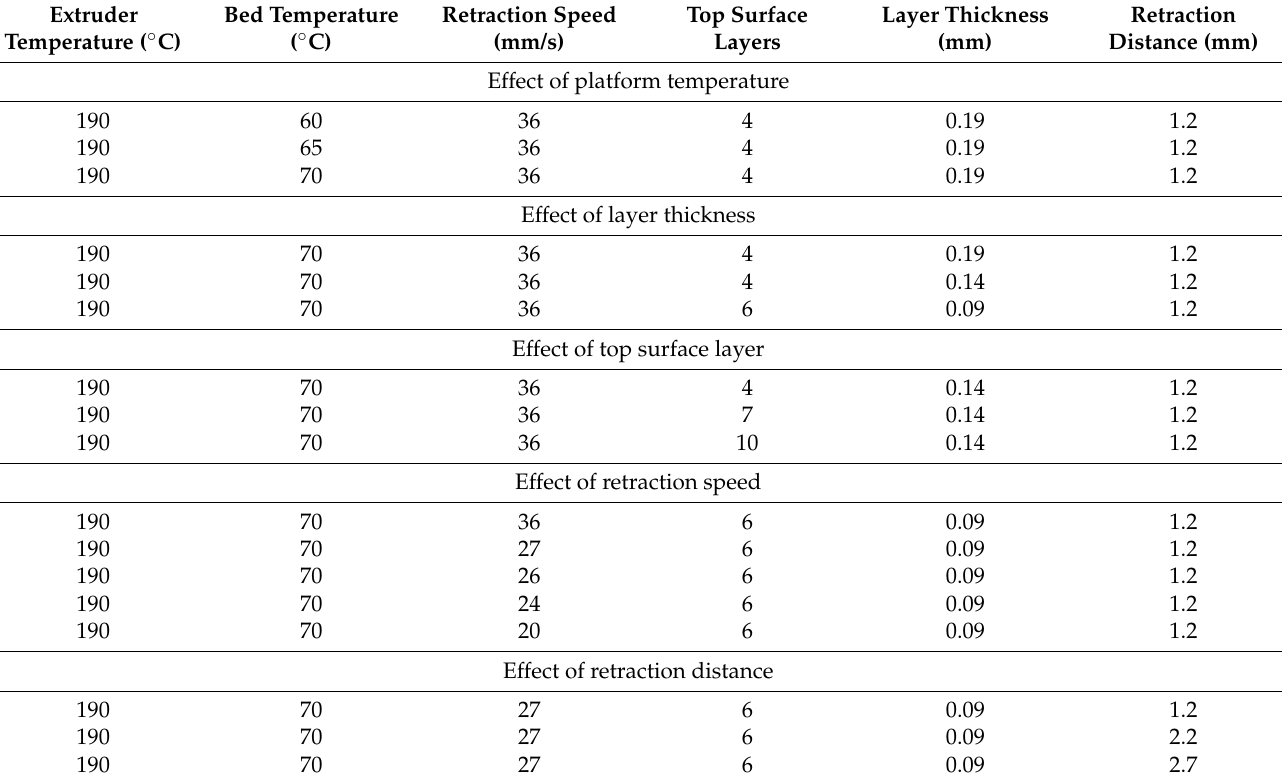
Table 4. Attempts to determine the best printing quality in the case of recycled